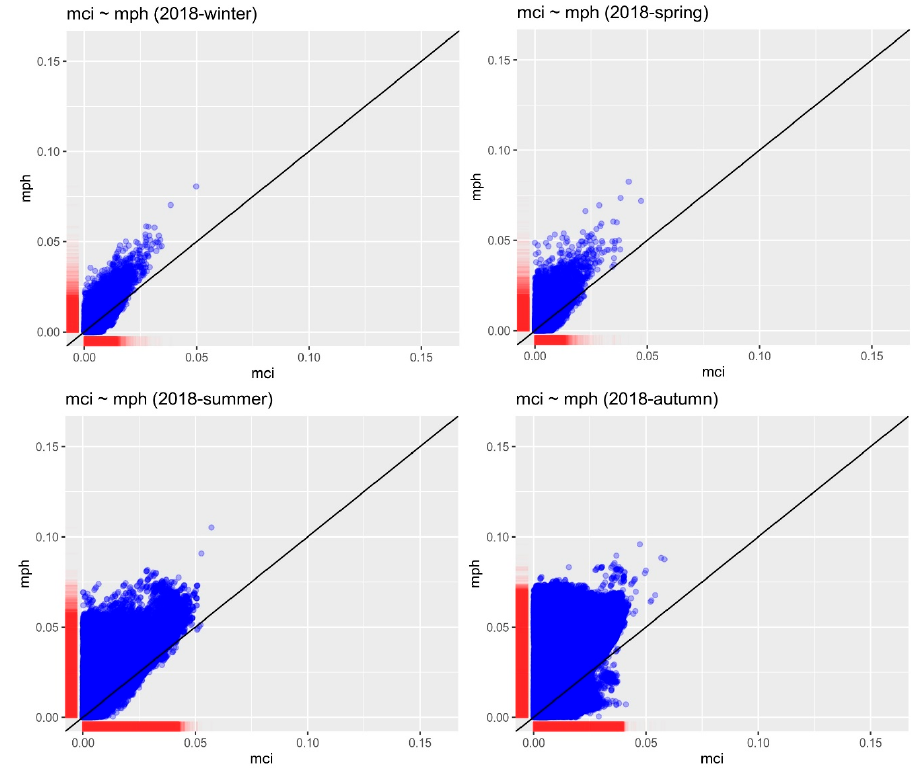
Figure A3. Scatter plot of MCI–MPH for the seasons of 2018.